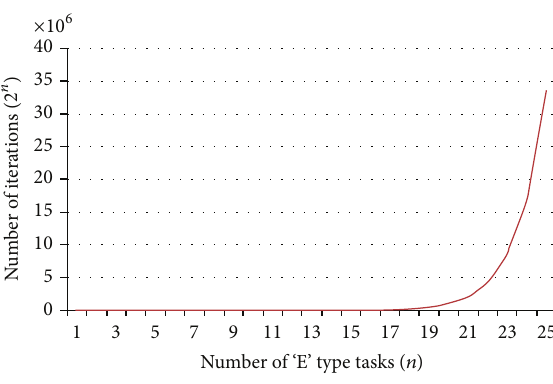
Figure 5: Number of iteration of EHA Vs number of “E” type